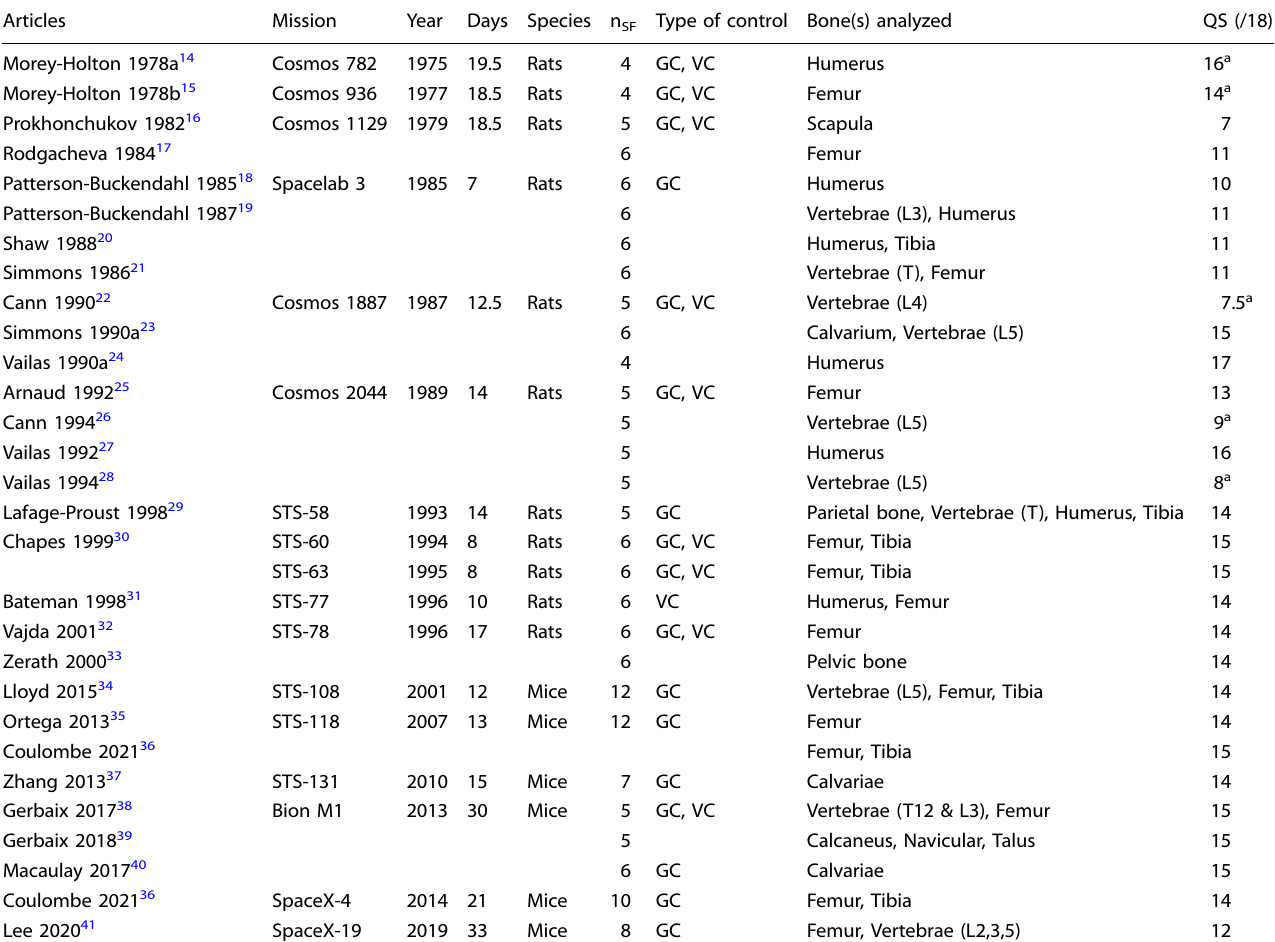
Table 2. Overview of articles included in meta-analysis.